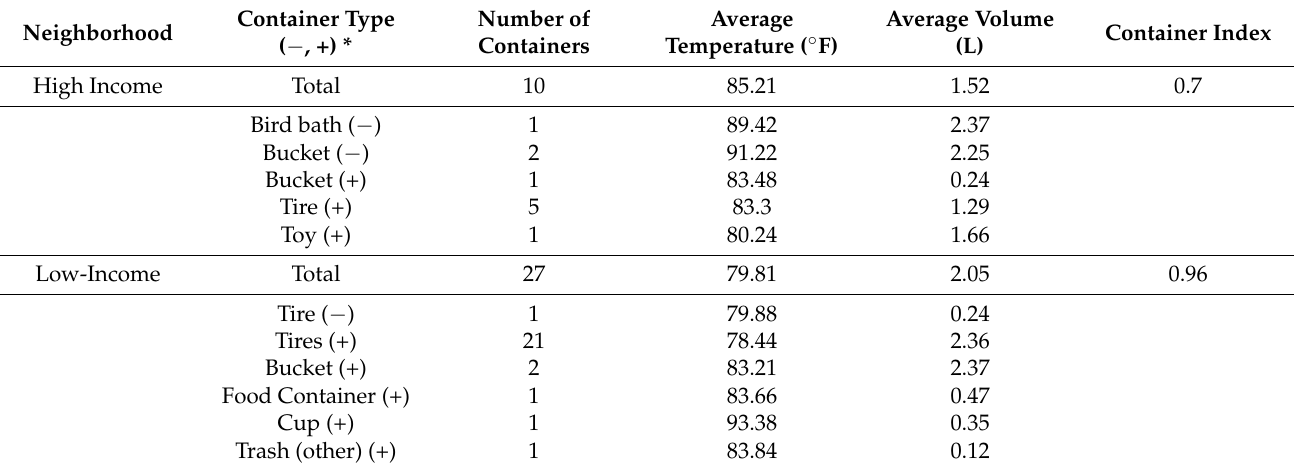
Table 2. Description of all water-filled containers found in our study